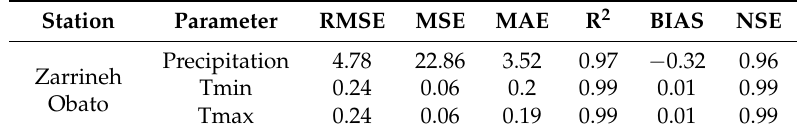
Table 3. Performance evaluation of the LARS-WG model in the basic period using different indices.